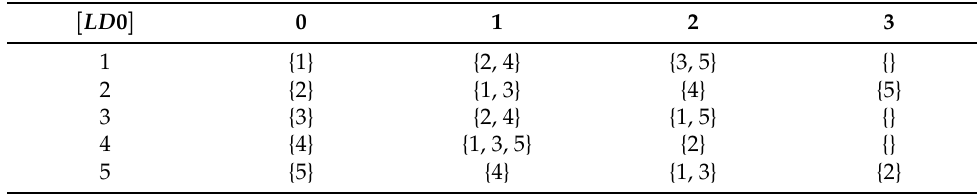
Table 2. Distance layers ( LD 0 i , k ← { j | Di i , j = k } ) for Figure 1.